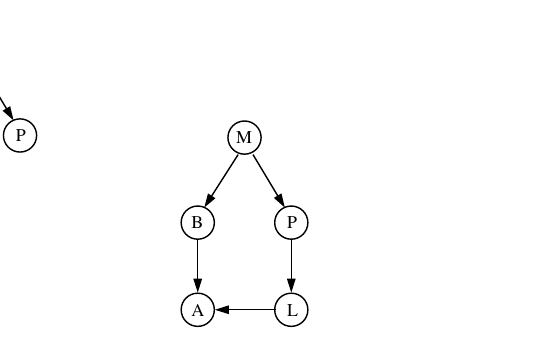
Figure 6. Acyclic digraphs without loops obtained when considering the parameters of the cases 1 ( left ), 2 (left also) and 3 ( right ) of Section 3.2.